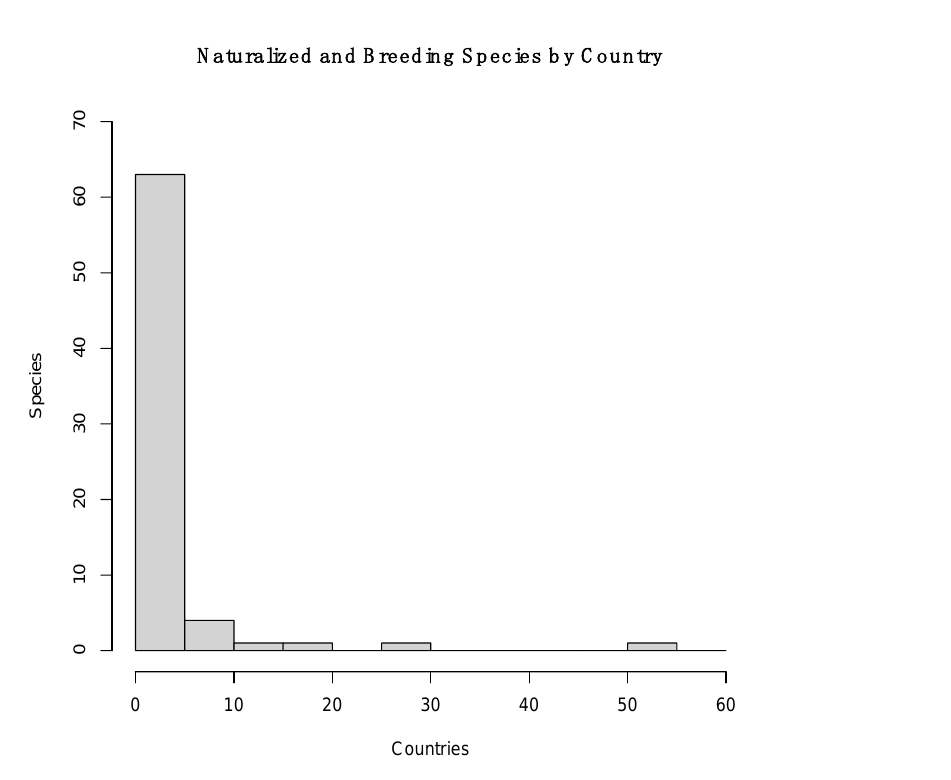
Figure 2. The frequency distribution of introduced and naturalized or breeding species of parrots (Psittaciformes) across countries.